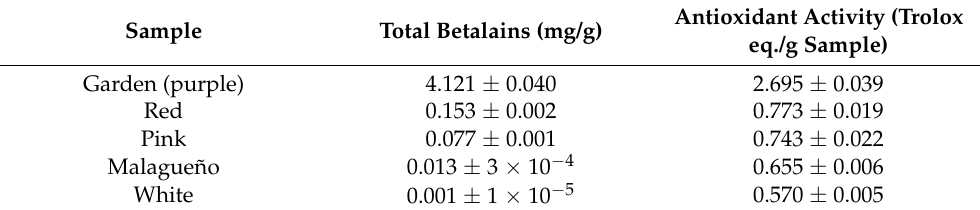
Table 4. Applicability of the developed method to commercial Opuntiia